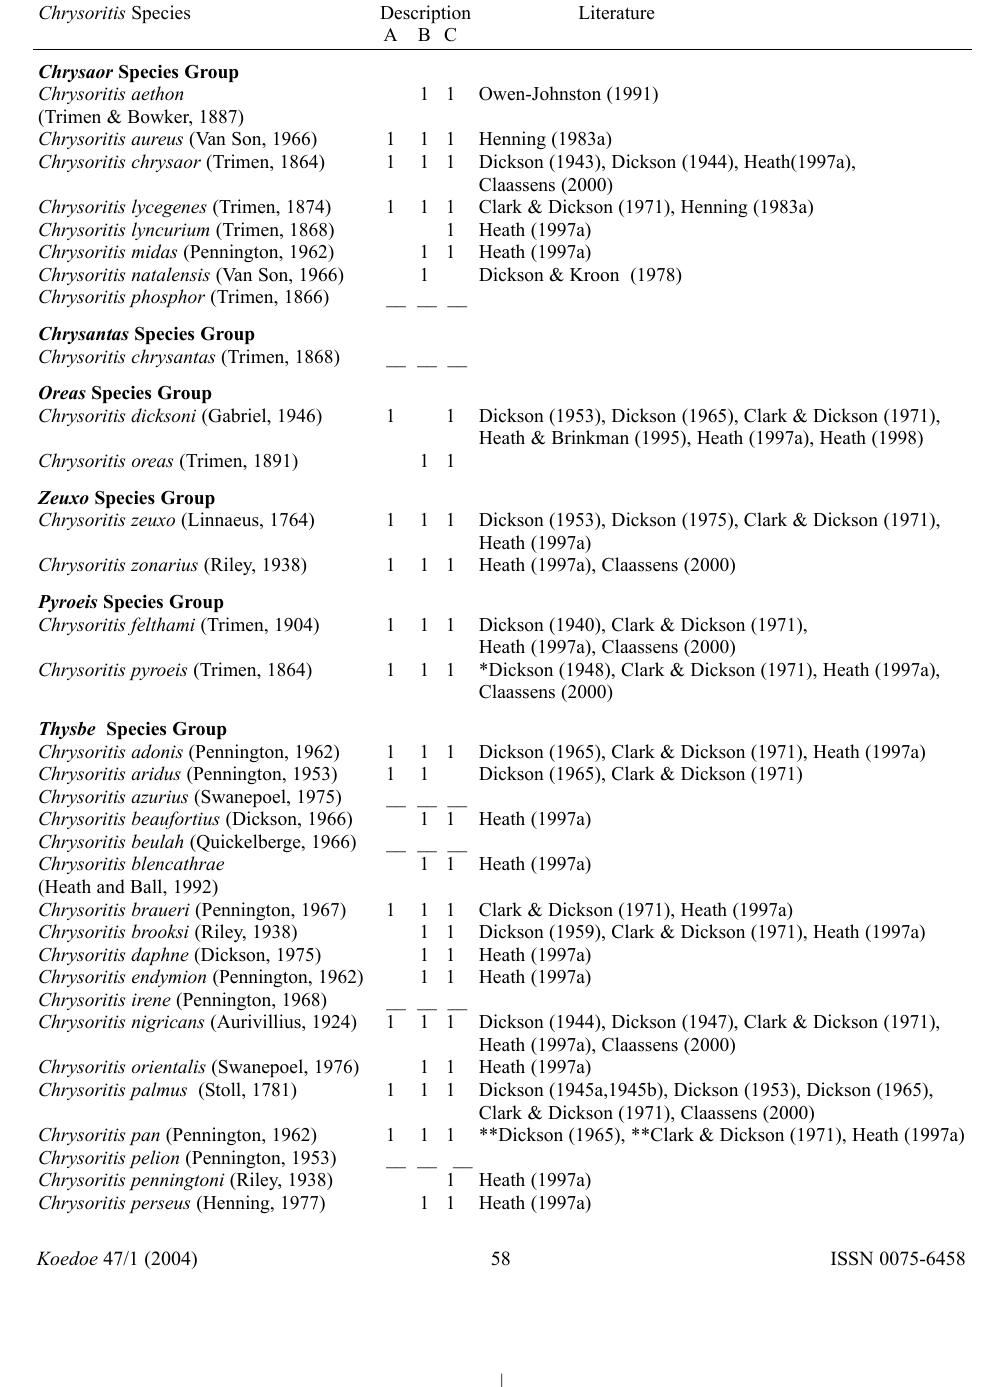
Table 1 A summary of the life-history studies published on Chrysoritis . The types of descriptions (A,B,C) include: A - a description of all or some of the stages (from egg to adult), B - the host plant has been reported, C - the attendant ant has been reported. The literature sources are those that reported previously unknown aspects of the life-histories. The literature sources used were, Dickson (1940, 1943, 1944, 1945a, 1945b, 1946, 1947, 1948, 1953, 1959, 1965), Clark and Dickson (1971), Dickson and Kroon (1978), S.F. Henning (1983a), Owen-Johnston (1991), Heath and Brinkman (1995), Heath (1997a), Heath (1998), Claassens (2000) and Heath